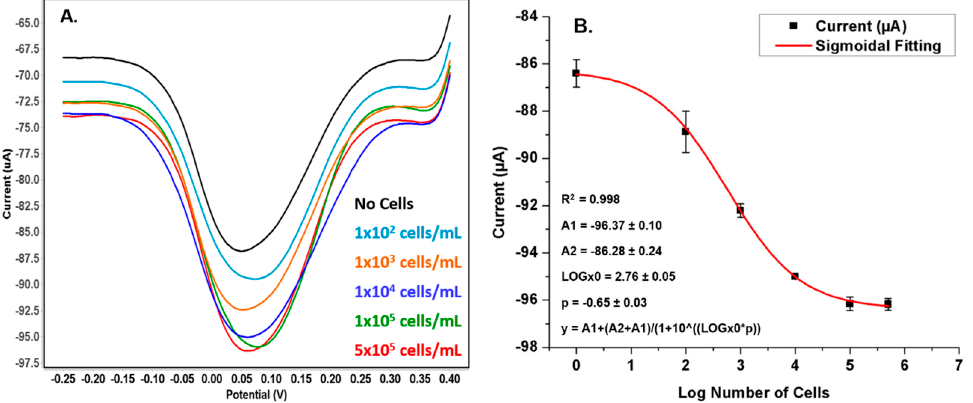
Figure 6. ( A ) Square wave voltammograms of the functionalized MWCNT/CS/GA/anti-OV6 Ab/BSA electrode with different number of HepG2 cancer cells contain hepatic oval cells (HOCs). ( B ) Plot of peak current response versus log number of hepatic cells and sigmoidal fitting. Potential step: 5 mV; amplitude: 25 mV; frequency: 15 Hz.